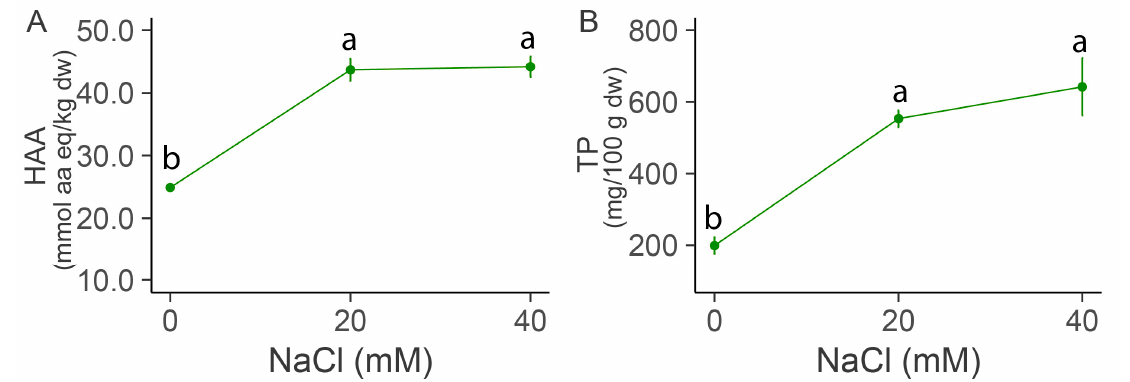
Figure 4. Effects of the NaCl in the nutrient solution on the hydrophilic antioxidant activity (HAA) and the total polyphenols (TP) in leaves: ( A ) HAA; ( B ) TP. Data are mean ± standard error of the mean. Different letters indicate significantly different means according to the Tukey HSD test ( p <